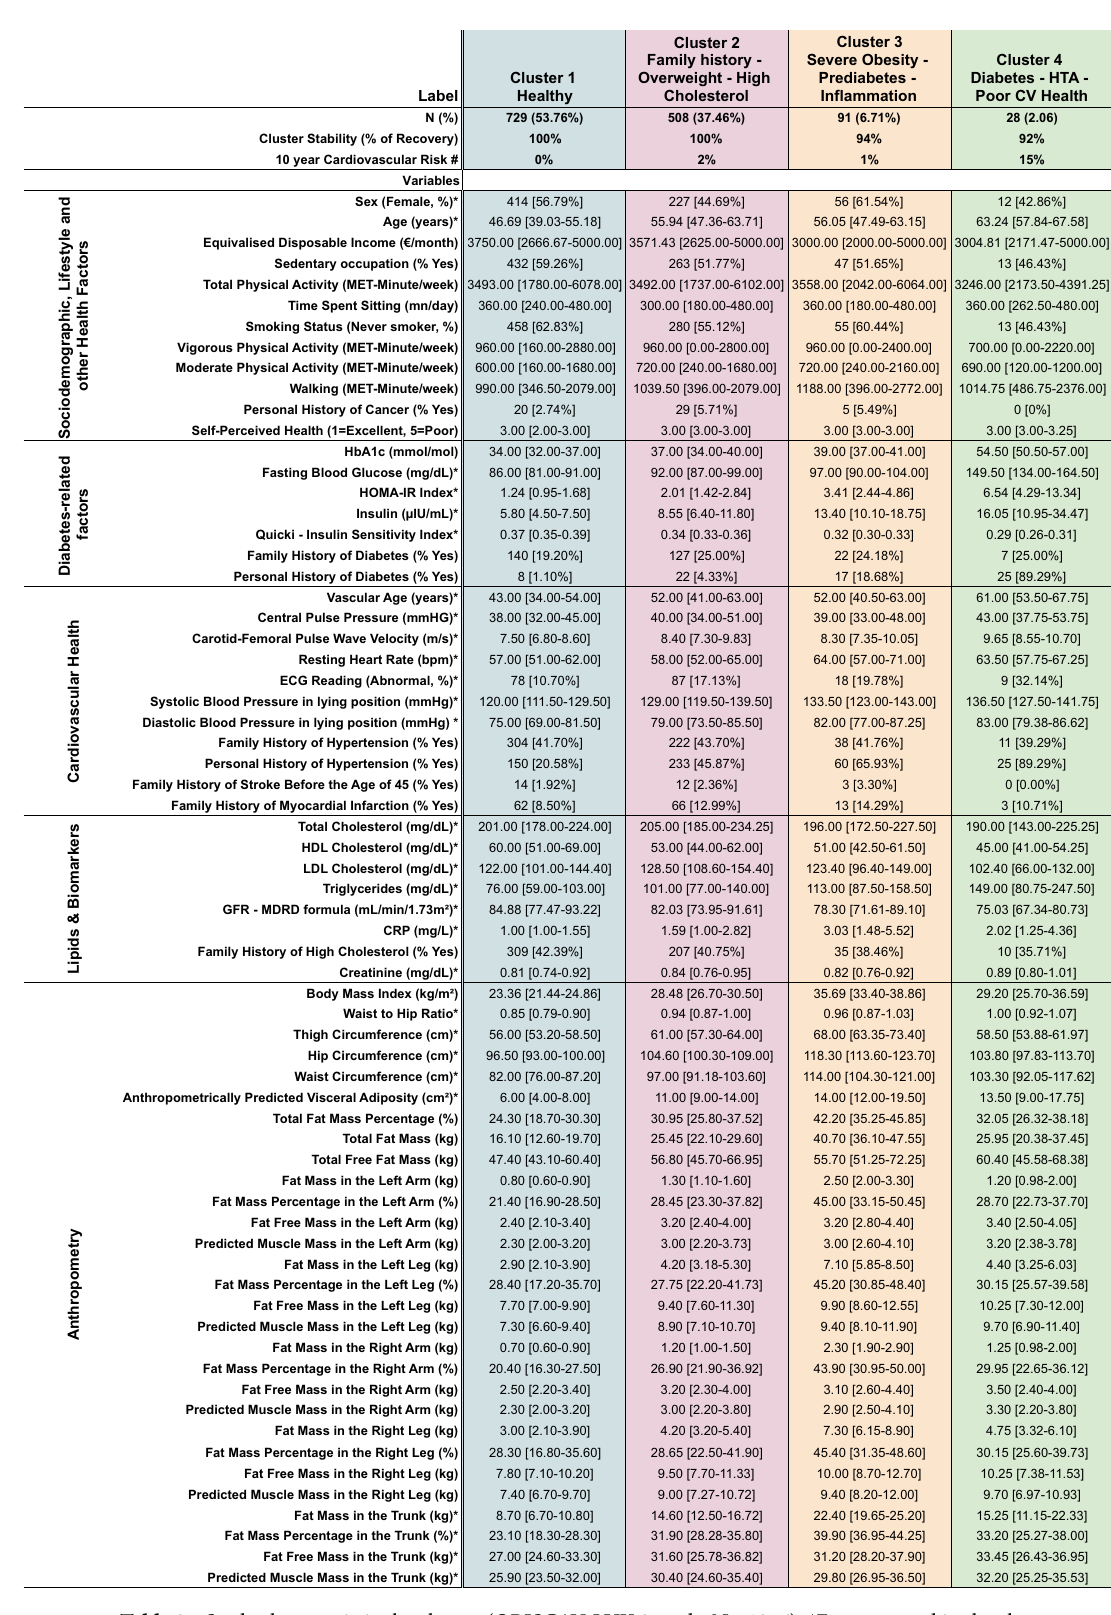
Table 2. Study characteristics by cluster. (ORISCAV-LUX 2 study, N = 1356). *Features used in the cluster analysis. # Estimated with the SCORE risk score for Clusters 1-3 and with the ADVANCE risk score for Cluster